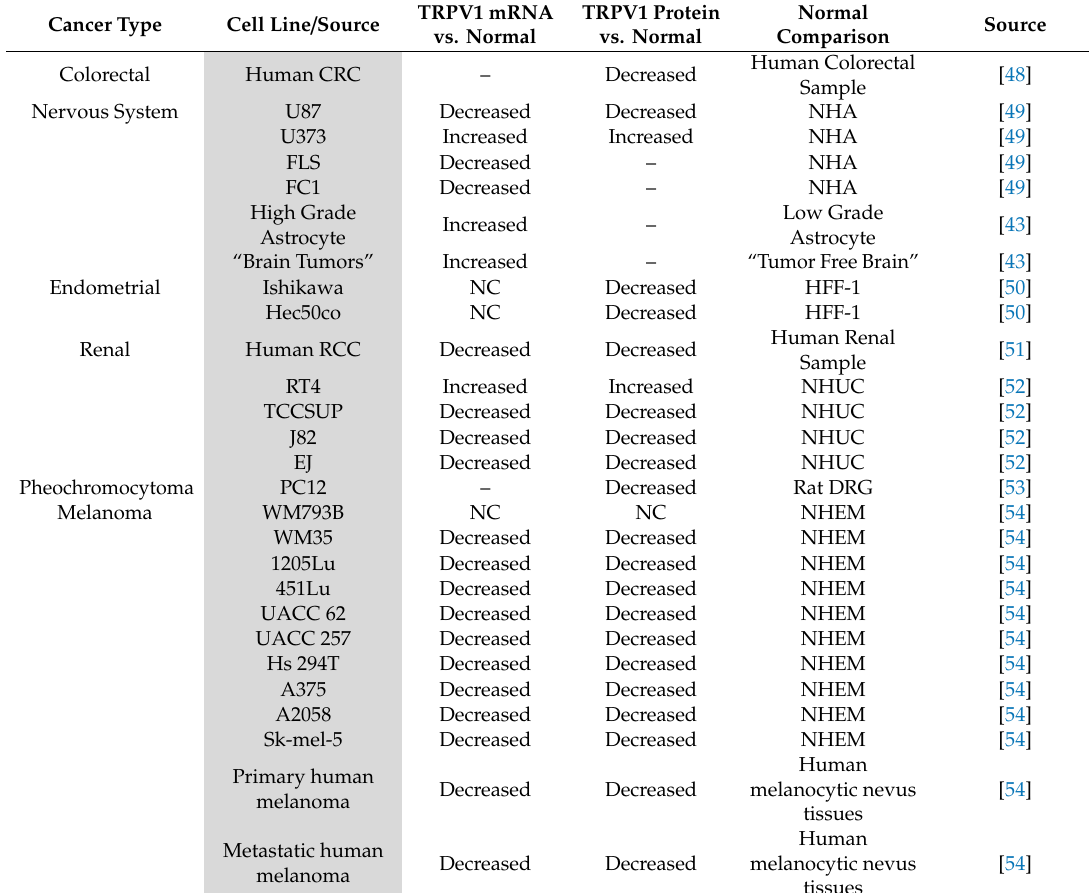
Table 2. mRNA and protein expression levels of the TRPV1 ligand-gated ion channel in cancerous cell lines, as compared to healthy tissues. The “TRPV1 mRNA vs. Normal” and “TRPV1 Protein vs. Normal” columns evaluate the mRNA and protein expression levels, respectively, observed in the cancerous cell lines relative to the corresponding control / healthy cells. “NC” indicates “No Change” in expression between the normal and cancerous tissues. Cancerous cells lines are highlighted in